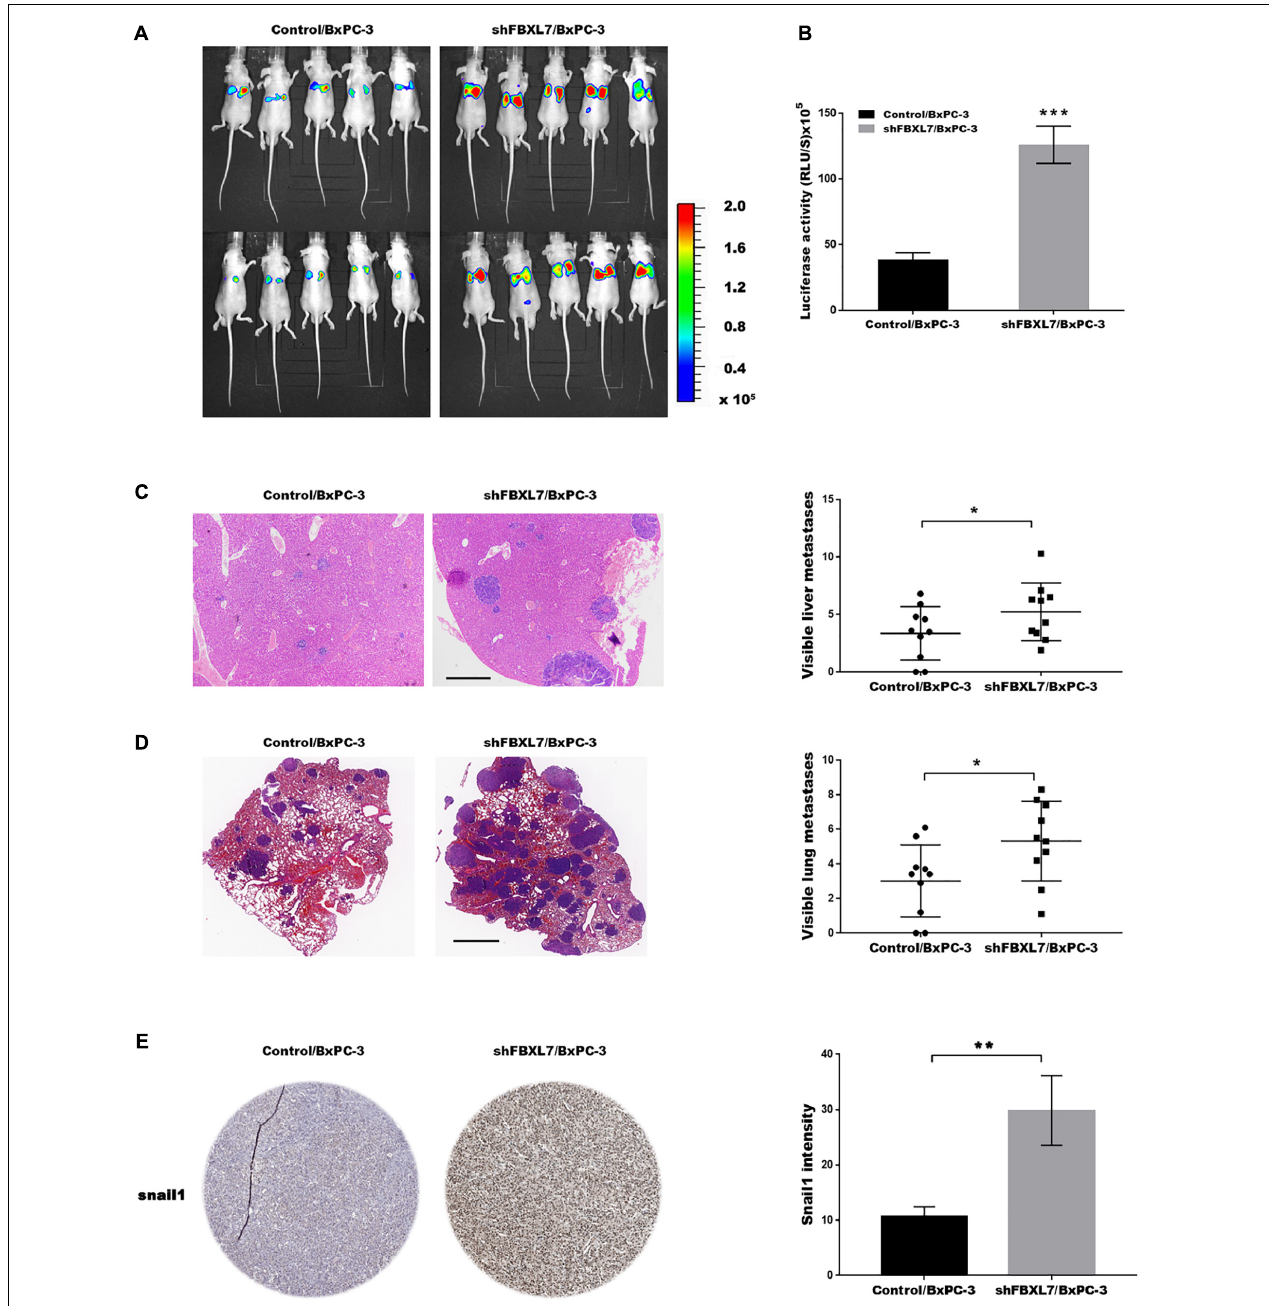
FIGURE 6 | FBXL7 inhibition facilitated tumor metastasis in vivo. (A,B) Cancer metastasis was assayed using bioluminescent imaging after FBXL knockdown. (C) After repressing FBXL7, the incidence and number of visible metastases in liver was assayed. Scale bar = 1 mm ( n = 10). (D) After repressing FBXL7, the incidence and number of visible metastases per lung in each cohort following inoculation was assayed. Scale bar = 1 mm ( n = 10). (E) IHC staining for snail1. Data represent means ± SD The significance determined by two-tailed Student’s t -test. * P < 0.05, *** P <